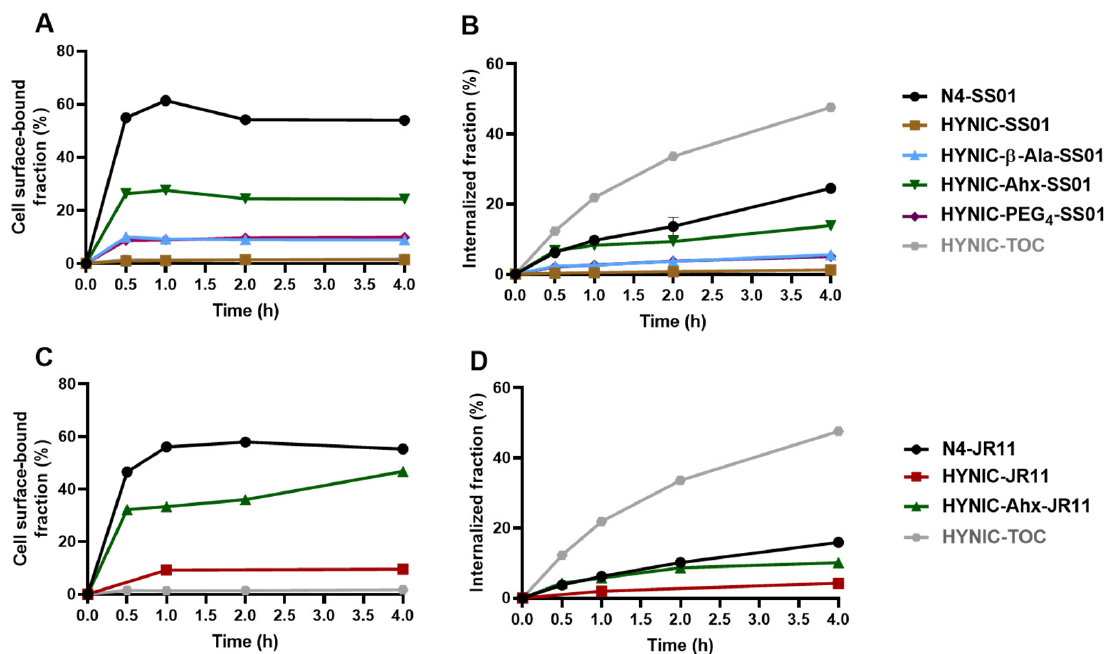
Figure 2. ( A , B ) Surface-bound and internalization fractions of all 99m Tc-labeled SS01 conjugates. ( C , D ) Surface-bound and internalization rates of all 99m Tc-labeled JR11 conjugates. For the sake of simplicity, [ 99m Tc]Tc has been omitted from the conjugates. All conjugates were compared to [ 99m Tc]Tc-HYNIC-TOC in HEK-SST2 at 37 ◦ C. Results are expressed as % (mean ± SD) of applied activity in the cells and normalized per million cells. All values refer to specific bound and internalization after subtracting the non-specific (measured in the presence of 1000-fold excess of blocking agent) from the total bound and internalized fractions.